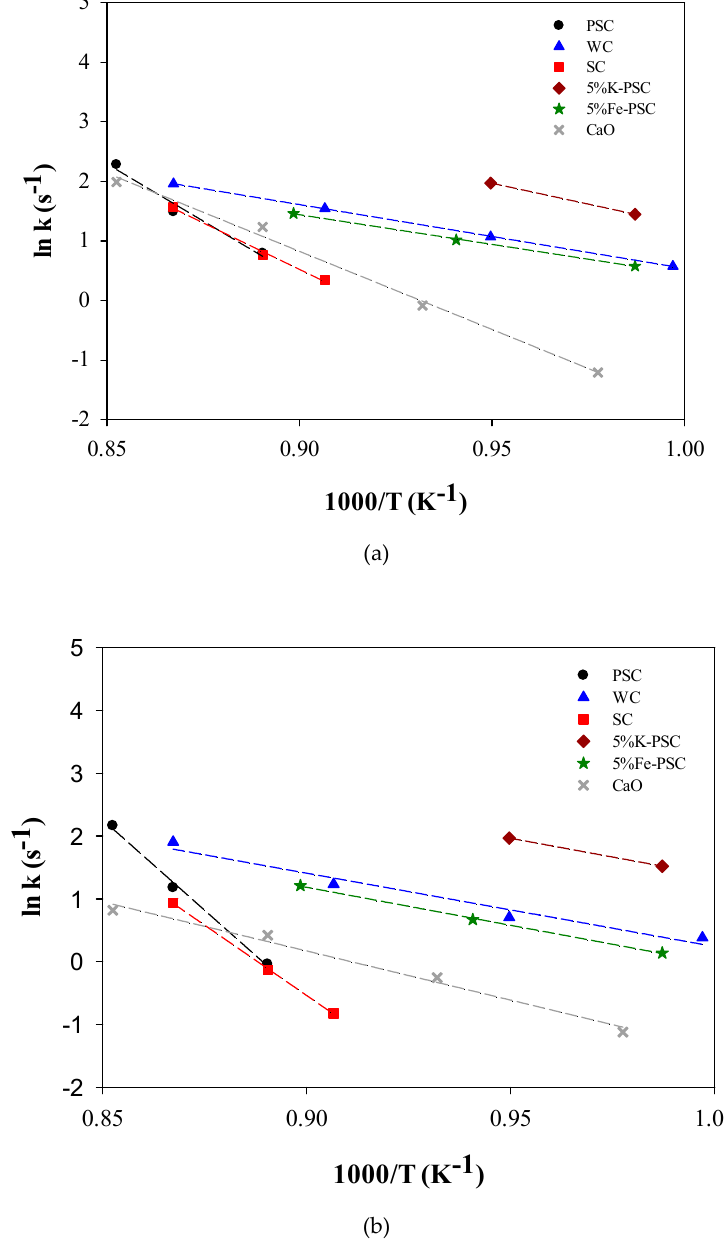
Figure 10. Temperature dependency of the apparent reaction rate constant according to Arrhenius’ law. Calculation by; ( a ) toluene conversions; and ( b ) naphthalene conversions.